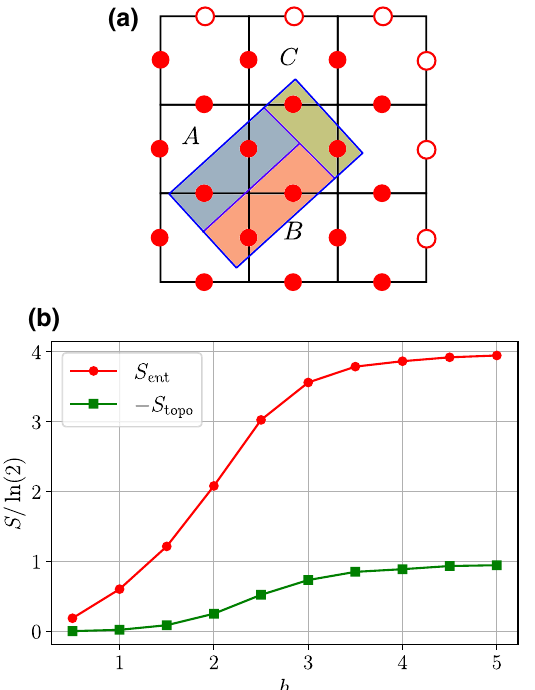
FIG. 10. (a) Graphical representation of the subsystem used to compute the topological and entanglement entropy, with the tri- partition A , B , C highlighted. Note that a total of N v = 5 vertices are cut by the outer edge of A ∪ B ∪ C . Open circles indicate the presence of PBCs in the lattice, thus identifying the upper edge with the lower one and the right edge with the left one. (b) Entan- glement and topological entropy as a function of the coupling h